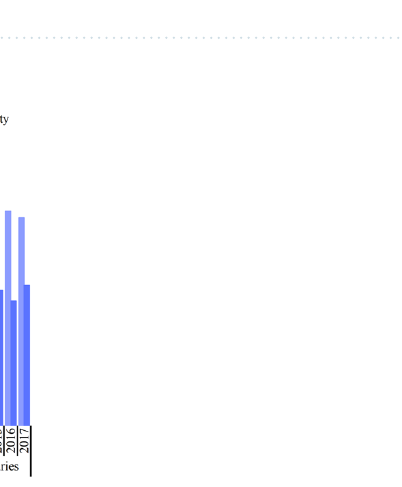
Figure 4. Age composition of deceased children under-five years old from 2008 to 2017: ( a ) Neonatal, ( b ) 29d- 12 month, ( c ) 13–59 months.